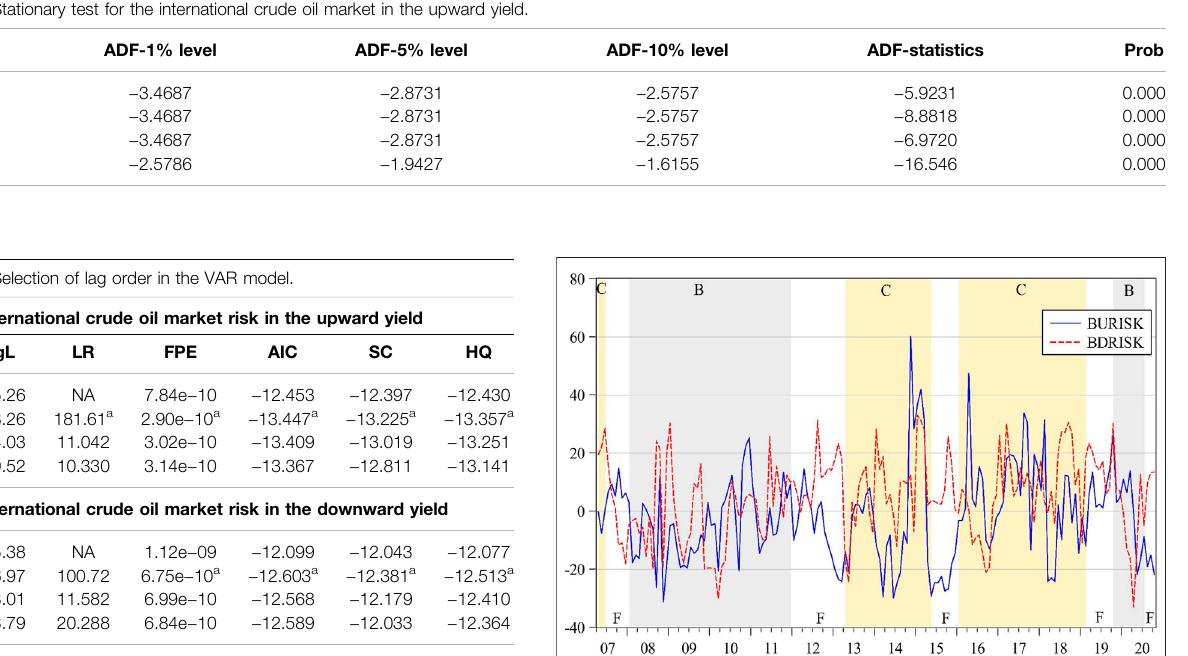
a Suggested lag orders through each criterion. TABLE 4 | Static risk spillover matrix between the international crude oil market and other markets. BRISK CRISK FRISK FROM